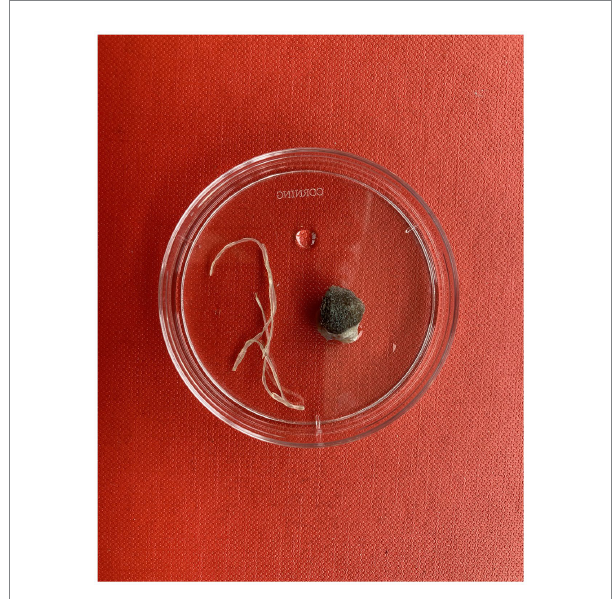
FIGURE 1 Dirofilaria repens adult extracted from the dog’s nodule in a 60 mm Petri dish.